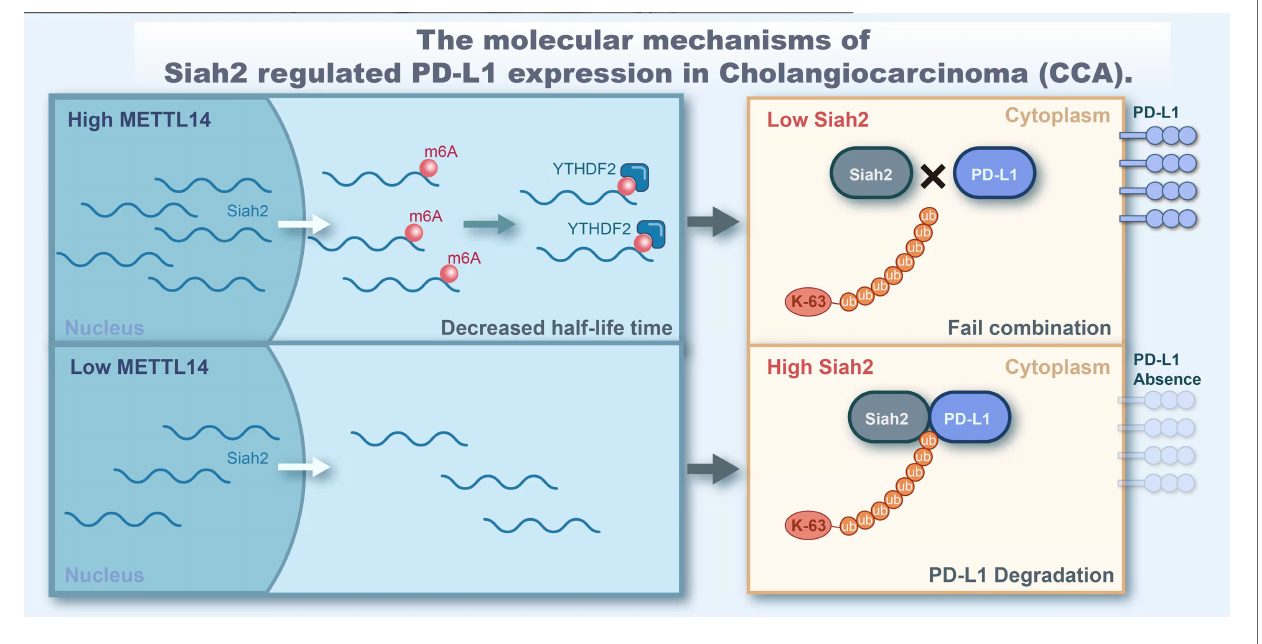
FIGURE 9 | The molecular of Siah2 regulated PD-L1 expression in Cholangiocarcinoma